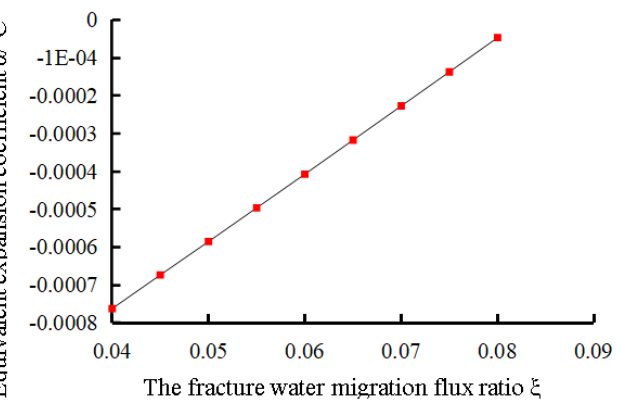
Figure 10. Variation of the equivalent thermal expansion coefficient with water transport flux.